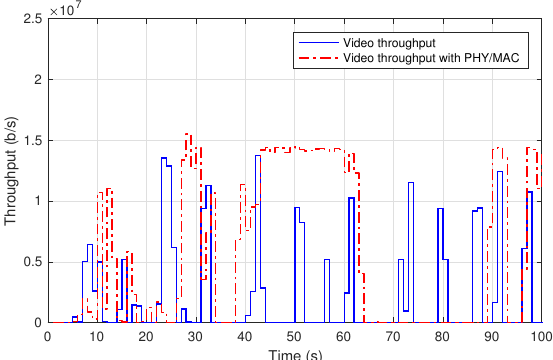
Figure 6. Data rates of SIP and Skype calls.